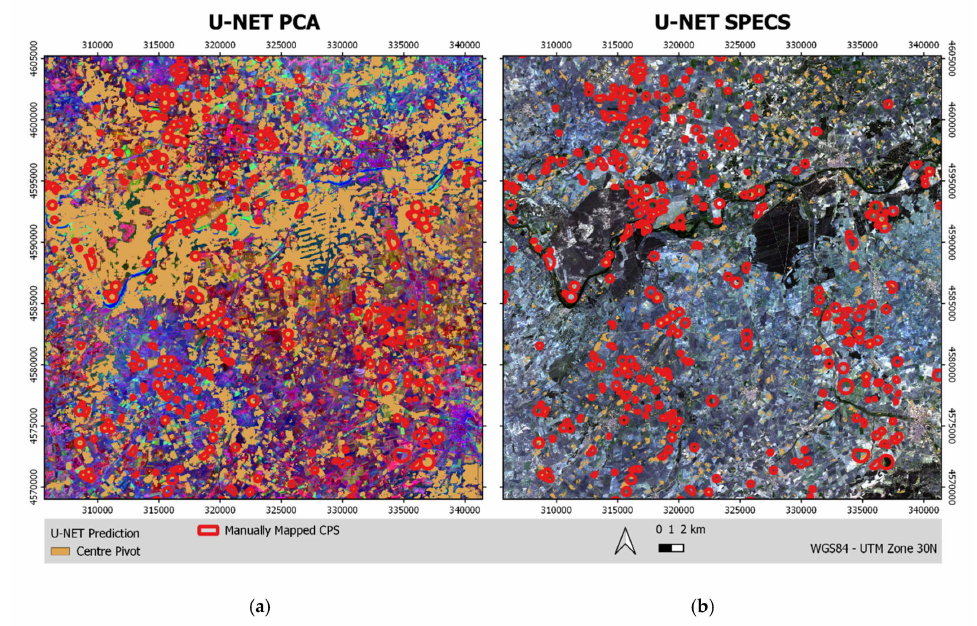
Figure 5. Semantic segmentation results (orange) of U-NET PCA ( a ) and U-NET SPECS ( b ) for the Duero study area. The manually mapped CPSs are displayed in red. In addition, the first three principal components are shown for U-NET PCA and the Sentinel-2 bands 2, 3, and 4 for U-NET SPECS in the